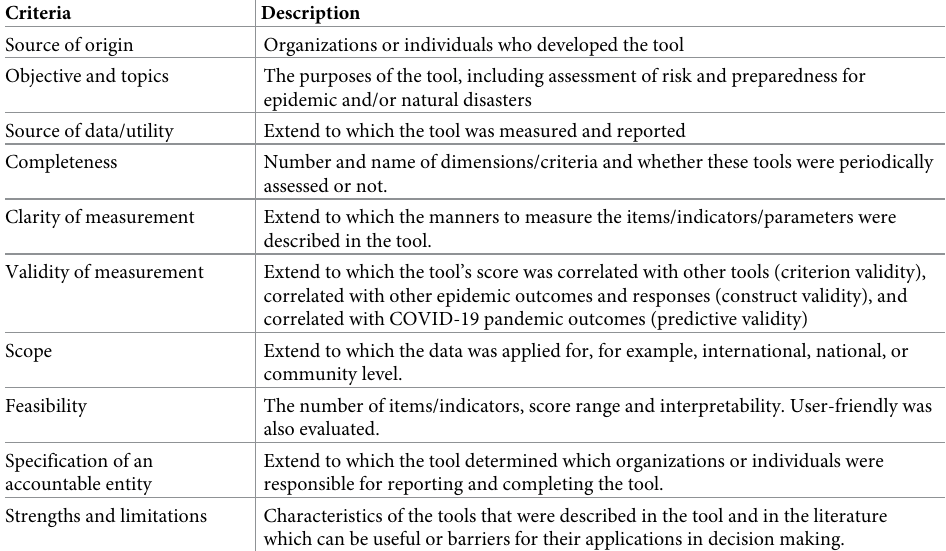
Table 2. Evaluation